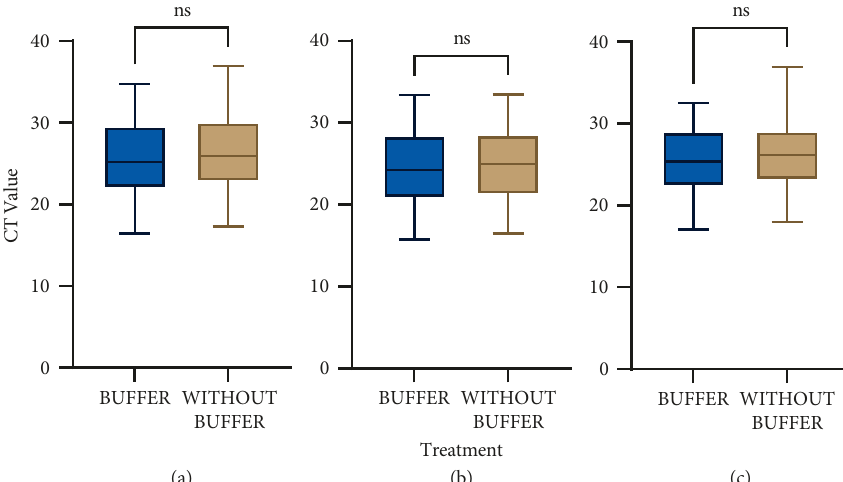
Figure 4: CTvalue of target genes for the safety test. CTvalues of COVID-19 samples stored in VITPAD ® ITM extracted with and without the lysis buffer: (a) ORF1ab; (b) N-gene; and (c) E-gene. ns—not statistically significant. P -value > 0.05 is considered not statistically